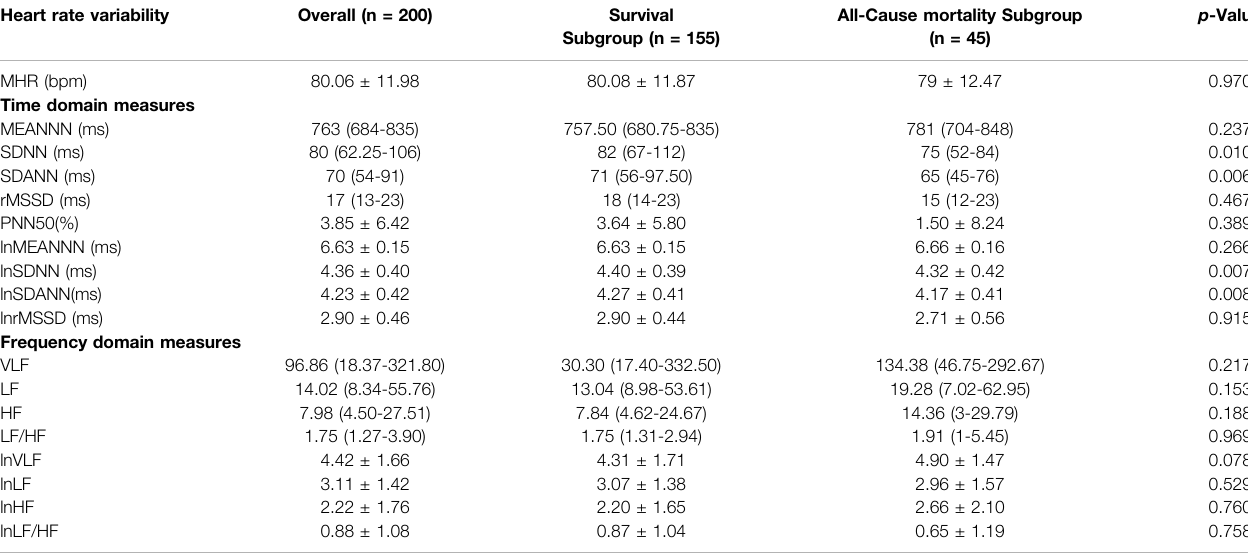
TABLE 2 | Baseline HRV indexes in survival and all-cause mortality subgroups of CKD5 patients. Heart rate